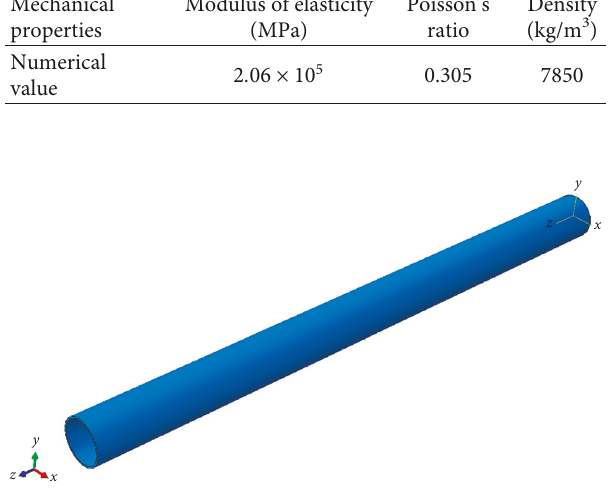
Figure 2: Finite element model of a straight pipe